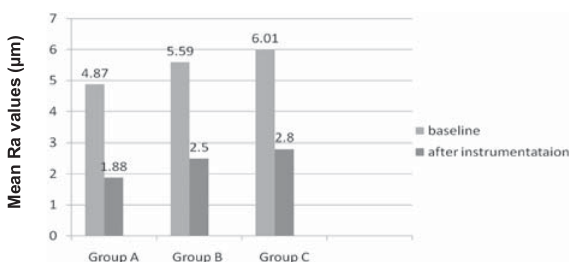
Figure 1- Mean Ra values (in μm) before and after instrumentation in all three